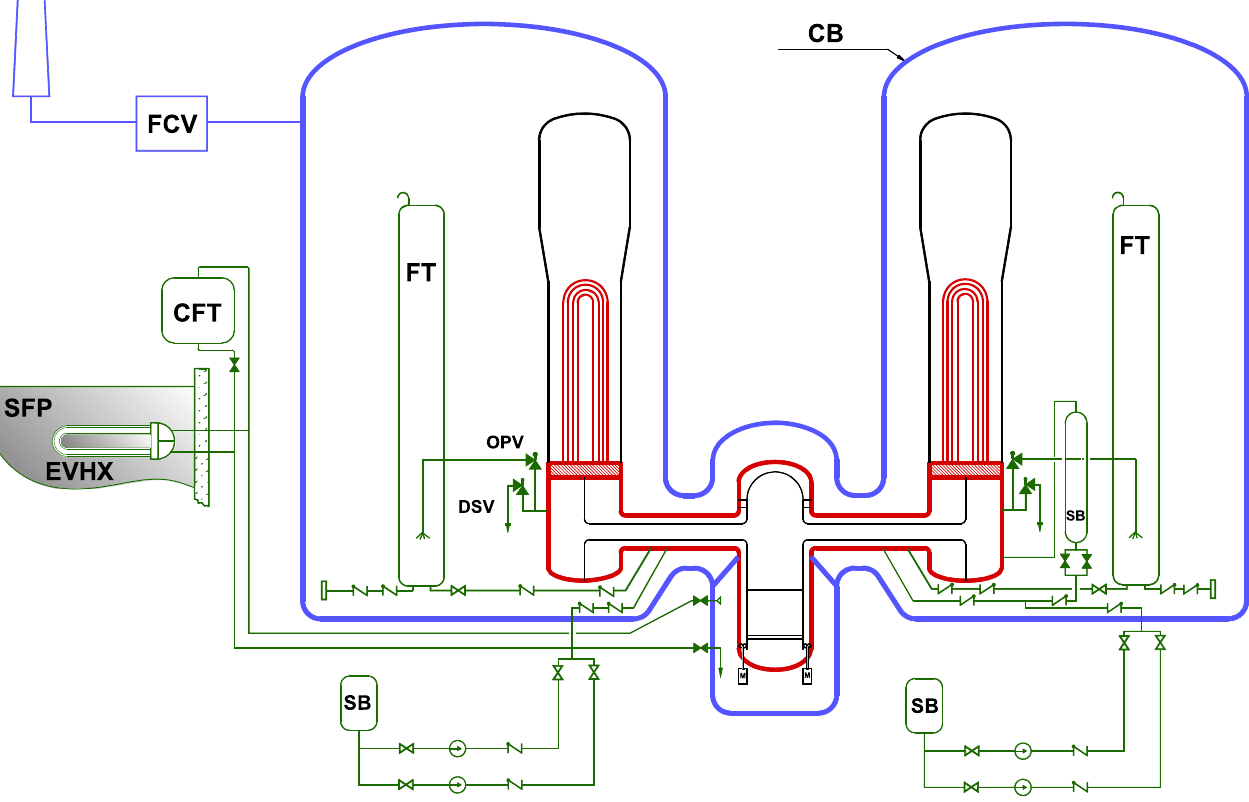
Fig. 3. Primary side safety systems. Essentially all primary side safety systems are shown in this fi gure, the only exceptions being: isolation valves in non-safety grade systems, hydrogen igniters/recombiners, and various instrumentation and surveillance equipment. The items indicated in the fi gure are: CB, containment boundary; FCV, fi ltered containment vent; SFP, spent fuel pool; CFT, cavity fl ooding tank; SB, safety boration tanks; EVHX, ex-vessel heat exchanger; FT, fl ooding tanks; DSV, depressurization system valves; OPV, overpressure protection